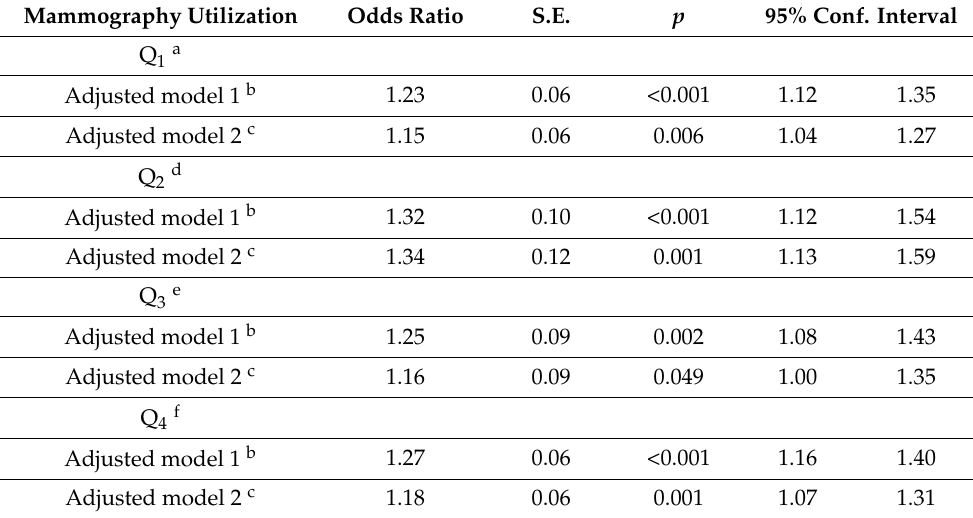
Table 3. Multiple logistic regression of mammography utilization based on IT-based healthcare communication with and without adjusting for mammography recommendation in 2015 (n = 12,483).